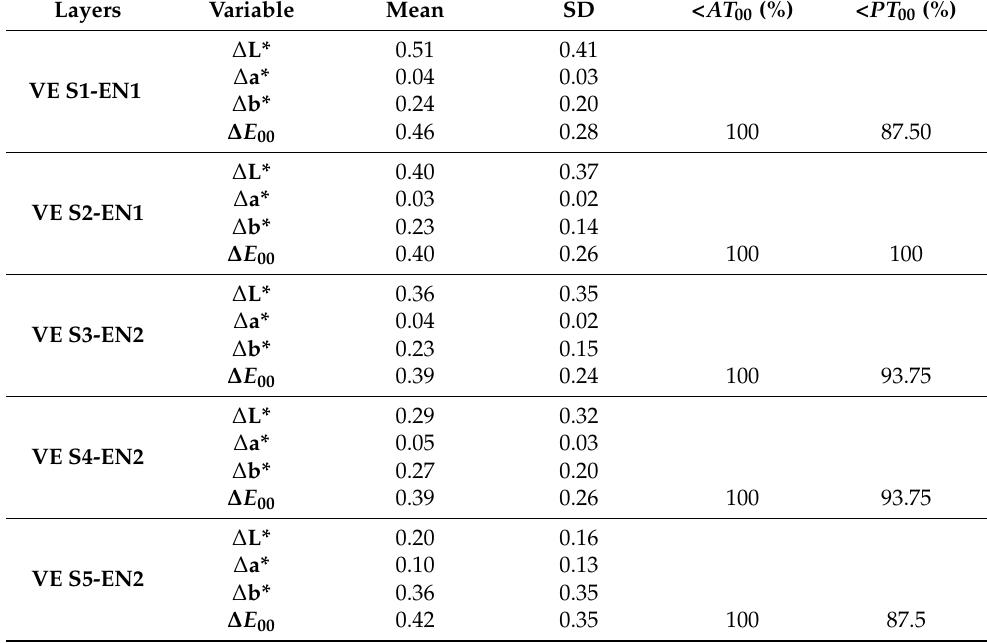
Table 6. Statistics of error metrics for different shades of VITA